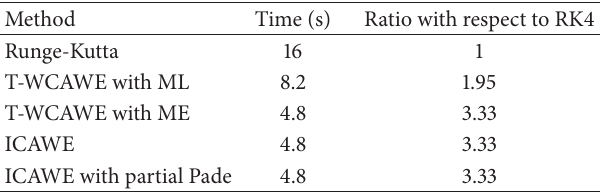
Table 1: Required time for different